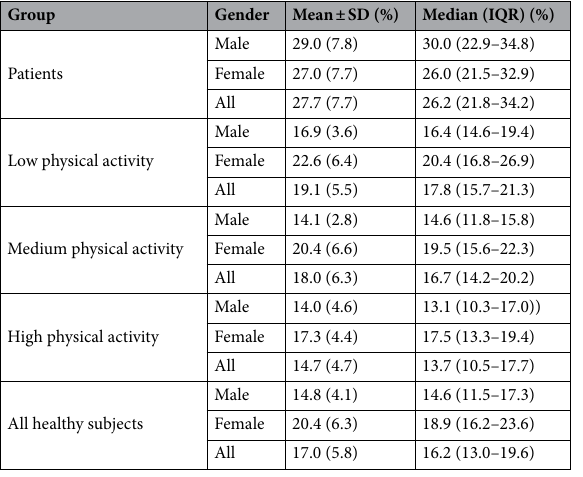
Table 2. Mean ± SD and Median (IQR) values for GMAX FF in the Patients, and Low, Mid and High activity groups and all healthy subjects